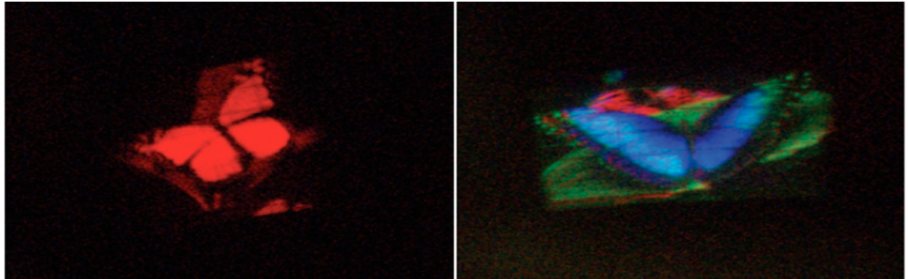
Figure 1. Images from a scanned, leaky mode electroholographic modulator. Reprinted with permission from